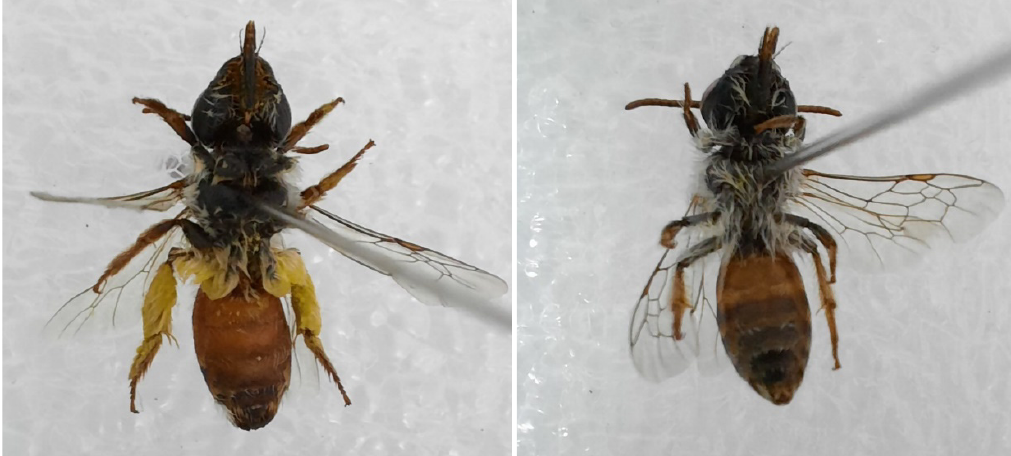
Fig 2 . Hind legs of A. savignyi : (a) female with load of pollen grains, (b) male.